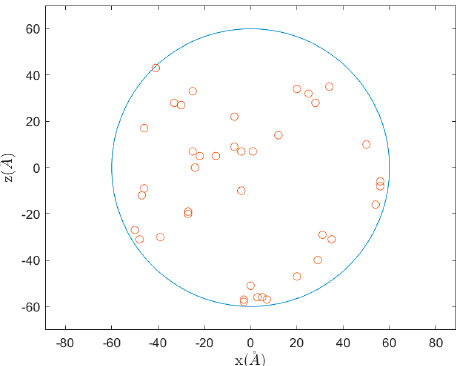
Figure 4. Approximate crack nucleation locations projected onto the x - z plane from 40 simulations with various stresses and